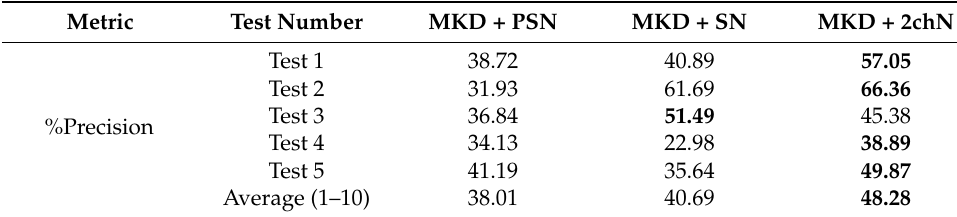
Table 5. Ablation experiment result of patch